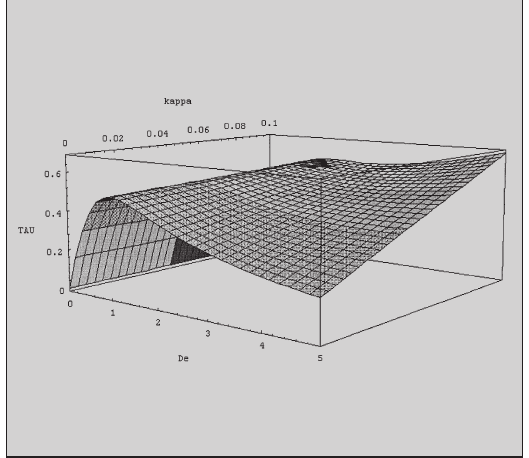
steady strain rates (the influence of the second derivative of the strain is also put in evidence). Figure 4 (right): Steady state solution (6) for the Jaumann derivative as a function of κ